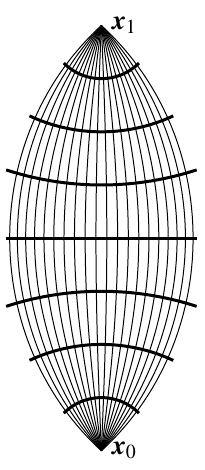
Figure 3: Another possible set of paths corresponding the same observed events as Figure 1, only here the corresponding field has a continuously-distributed set of phase